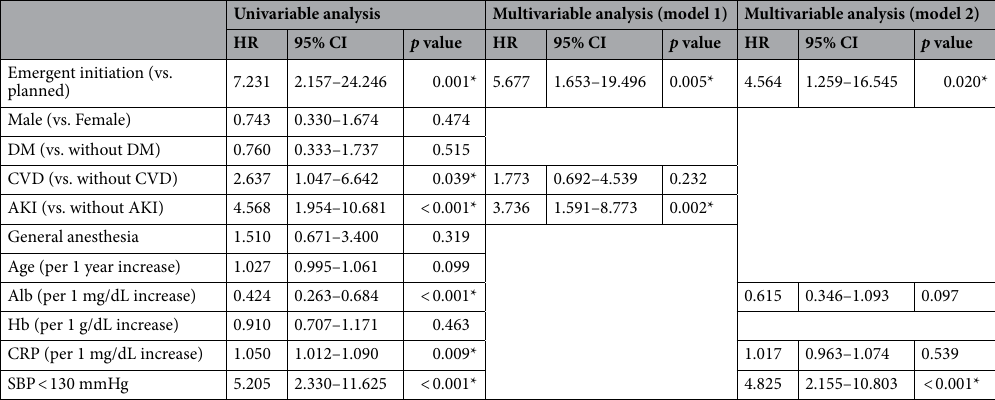
Table 4. Analysis of the relationship between emergent initiation of dialysis and mortality rate (C in Fig. 3). Alb, albumin: Hb, hemoglobin; CRP, C-reactive protein; SBP, systolic blood pressure. * p value < 0.05.